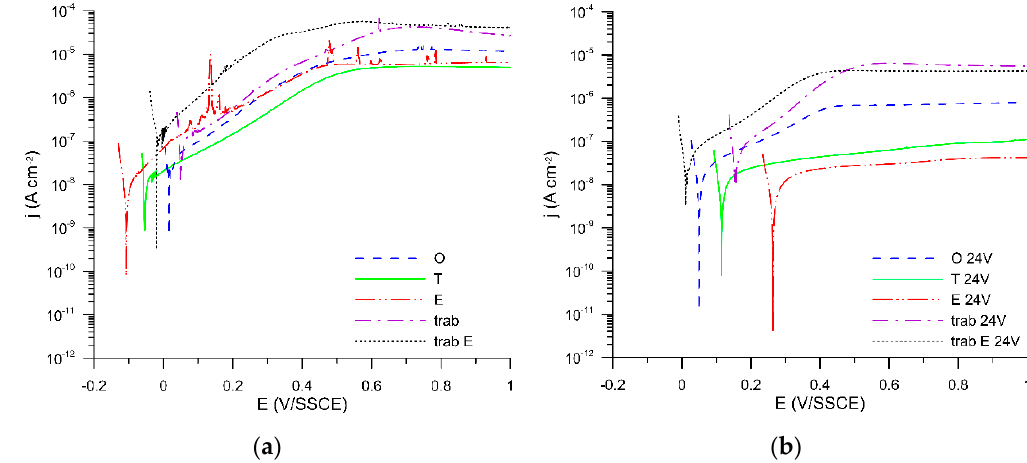
Figure 6. The potentiodynamic curves of specimens in physiological solution: ( a ) surfaces without anodization, ( b ) anodized surfaces.